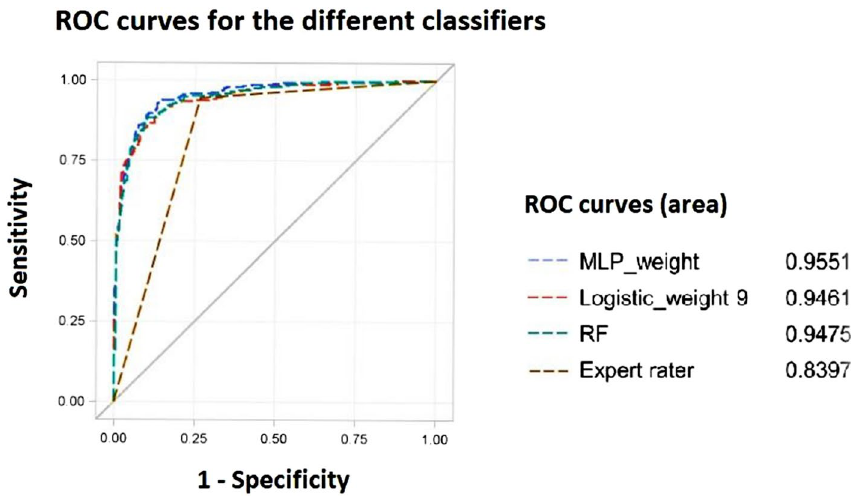
Figure 4. ROC curves for the different classifiers. The figure shows the receiver operator characteristic (ROC) curves for comparing the performance of the cross-validated multilayer perceptron neural network (MLP), random forest (RF) and logistic regression models with the expert rater. The logistic regression model was trained with a weighting factor 9 and the MLP model with a weighting factor of 3.06 for false negatives to achieve the same sensitivity as the expert rater at a cut-off point for the estimated probability of EBUS-positivity of 0.5. In addition, the ROC curve for the MLP trained with a weighting factor of 10 for EBUS-positives is